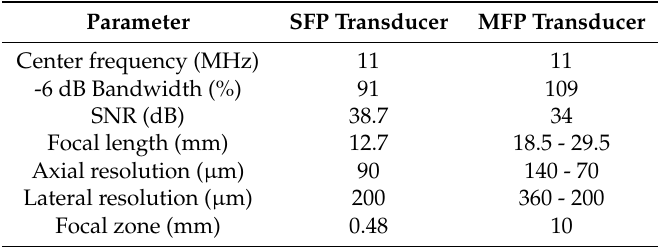
Table 4. Operating parameters of ultrasonic transducers.